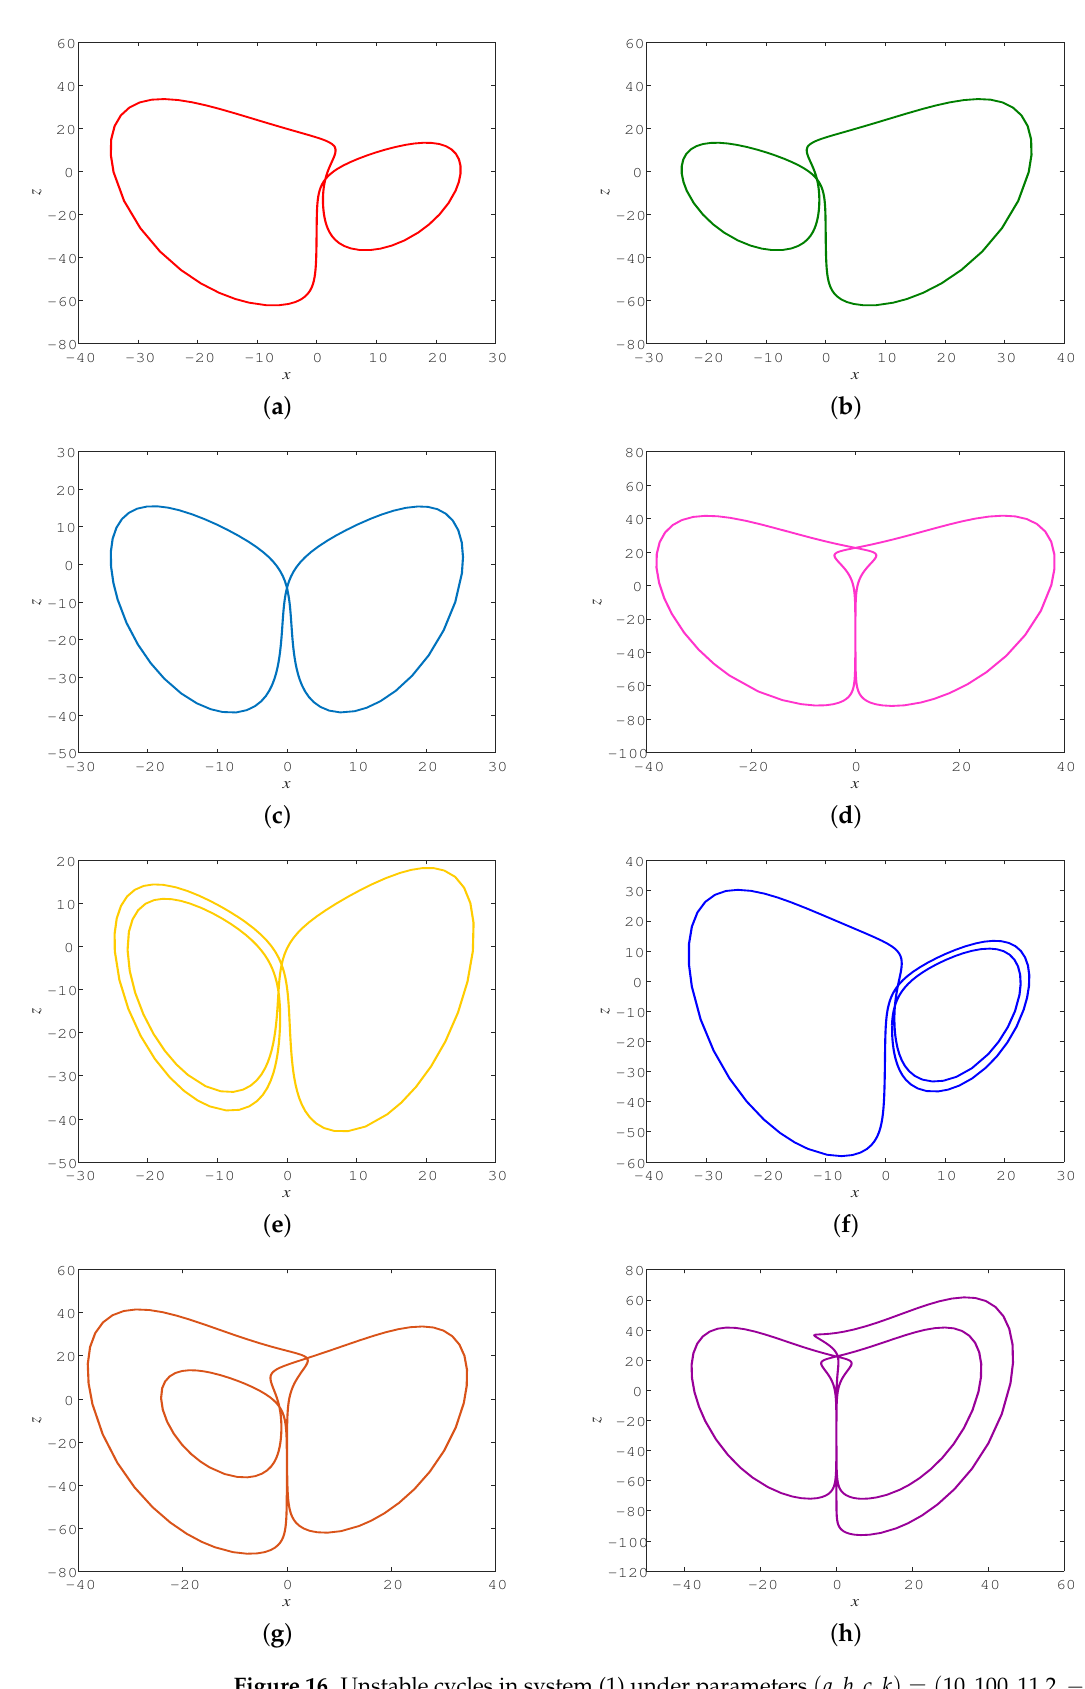
Figure 16. Unstable cycles in system (1) under parameters ( a , b , c , k ) = ( 10,100,11.2, − 0.2 ) : ( a ) cycle 12; ( b ) 03; ( c ) 01; ( d ) 23; ( e ) 001; ( f ) 112; ( g ) 023; and ( h )